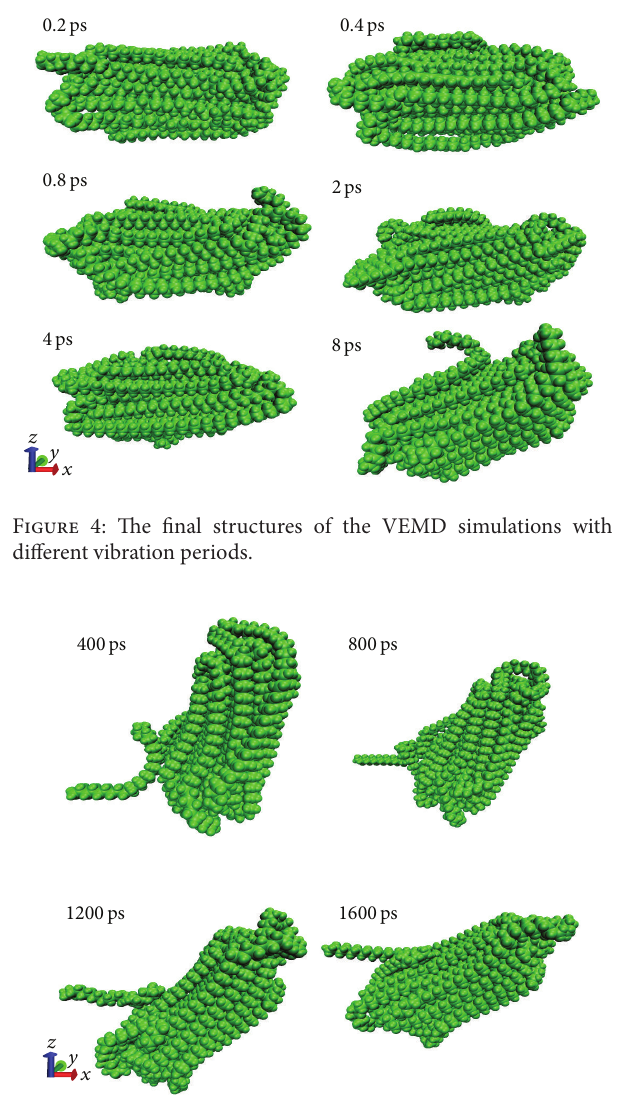
Figure 5: Snapshots at 400ps, 800 ps, 1200 ps, and 1600ps during the VEMD simulation with 8 ps vibration